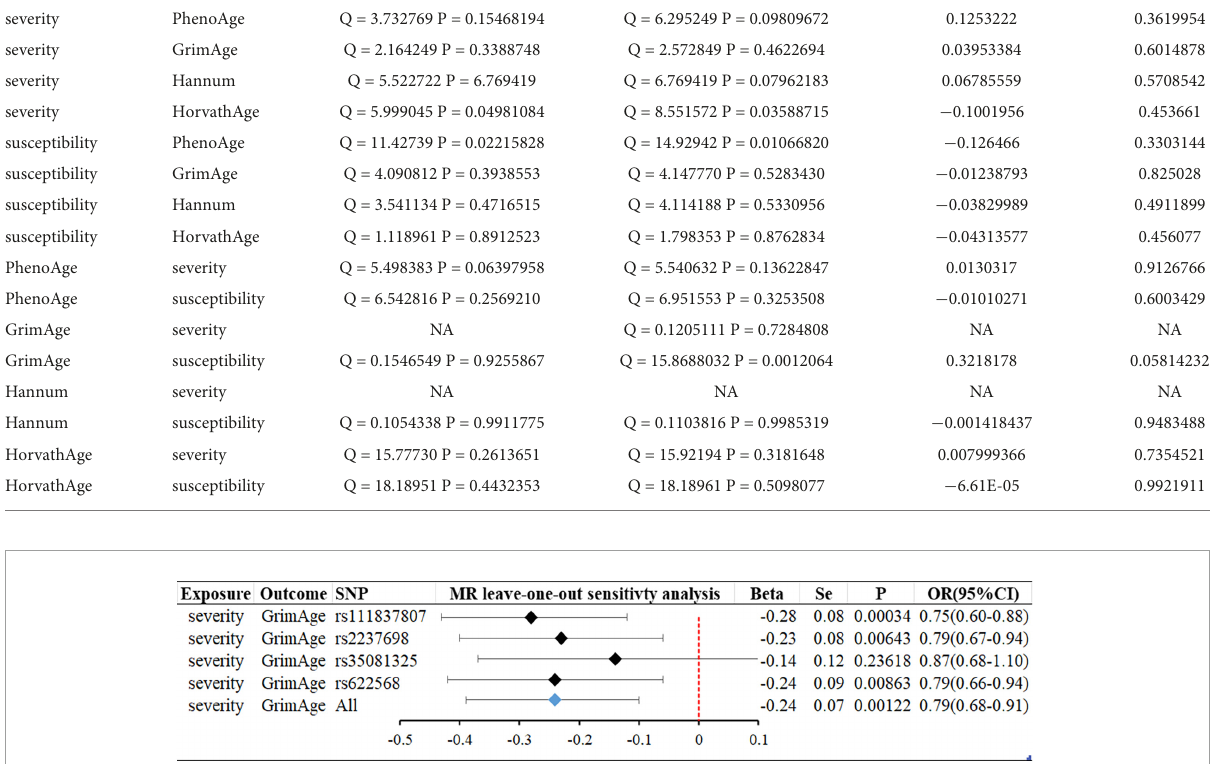
FIGURE3 MR “leave-one-out” sensitivity analysis “COVID-19 severity” on “GrimAge.” “Leave-one-out” plot to visualize the causal effect of COVID-19 severity on the risk of GrimAge when leaving one SNP